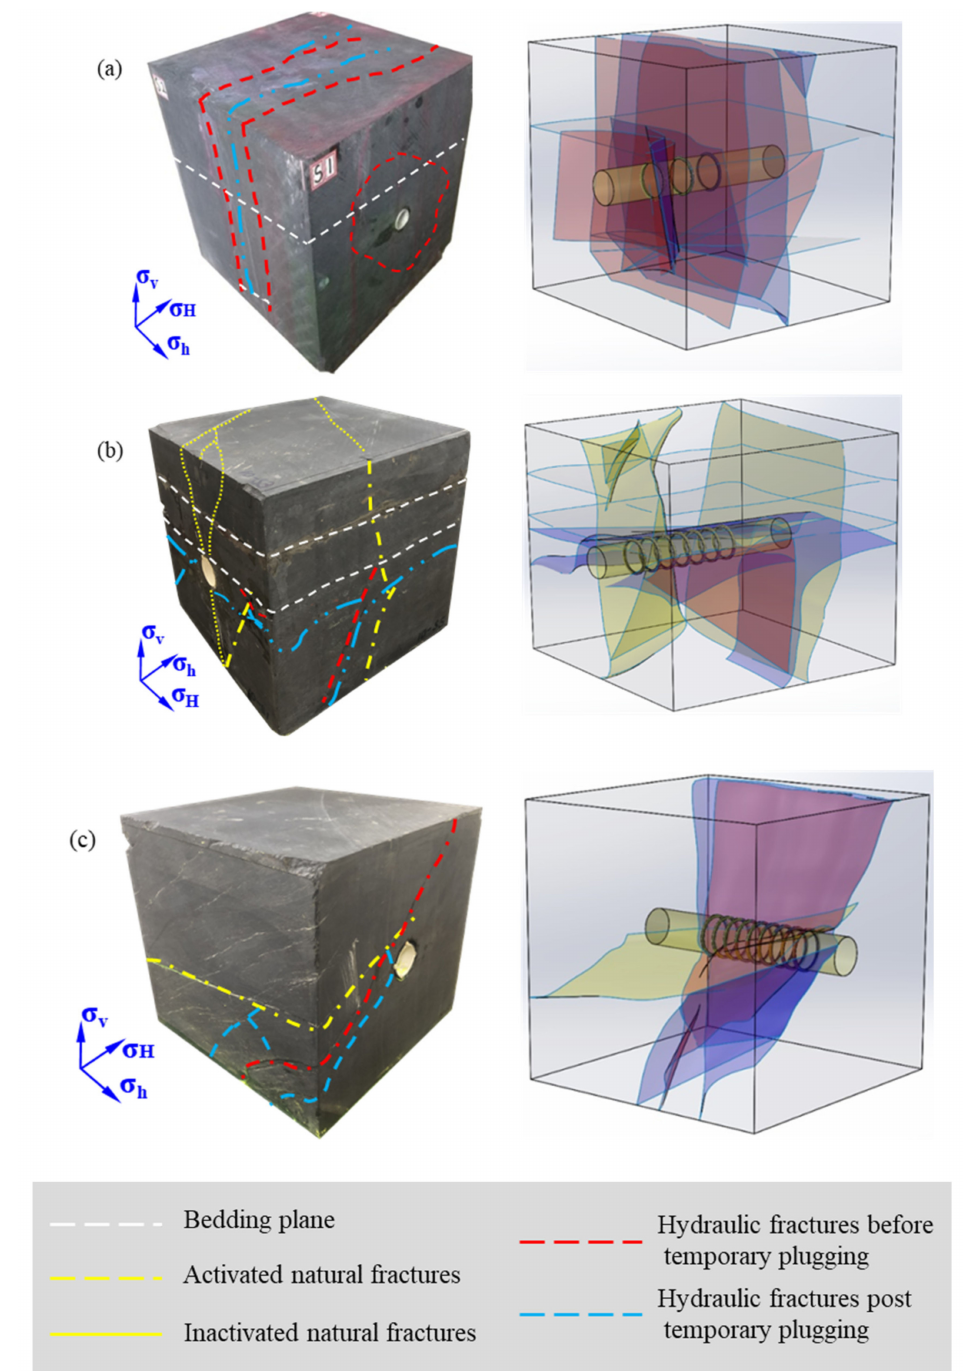
Figure 5. Fracture geometry and 3D reconstruction of temporary plugging fracturing under different cluster numbers in a stage: ( a ) Specimen 5#, ( b ) Specimen 8#, ( c ) Specimen 9# (left: apparent fracture geometry of rock sample, right: 3D reconstruction of fracture